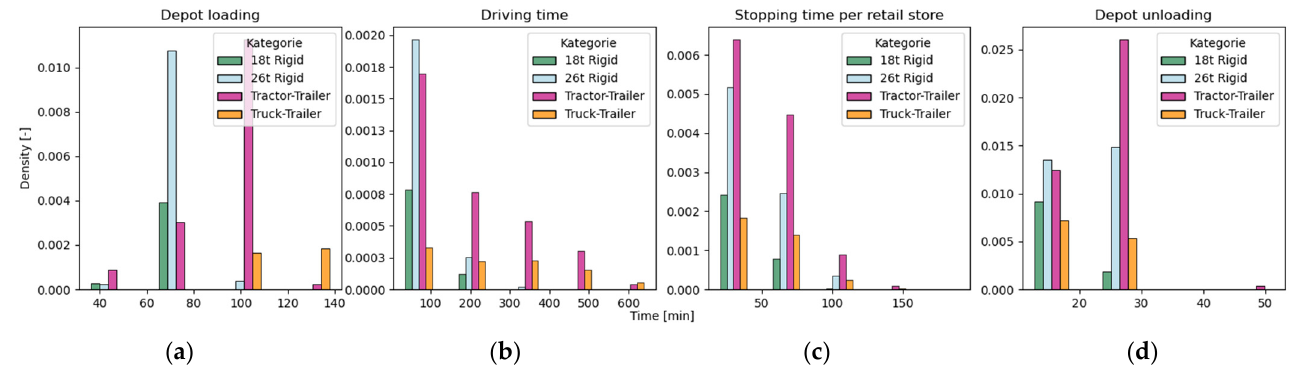
Figure 3. Evaluation of vehicle operating times per tour across both depots and per truck class; ( a ) Vehicle loading at the depot; ( b ) Driving time; ( c ) stopping time per retail store; ( d ) Vehicle unloading at the depot—own illustration.